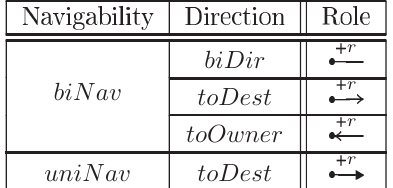
Table 2. Forms of roles according to navigability and direction.